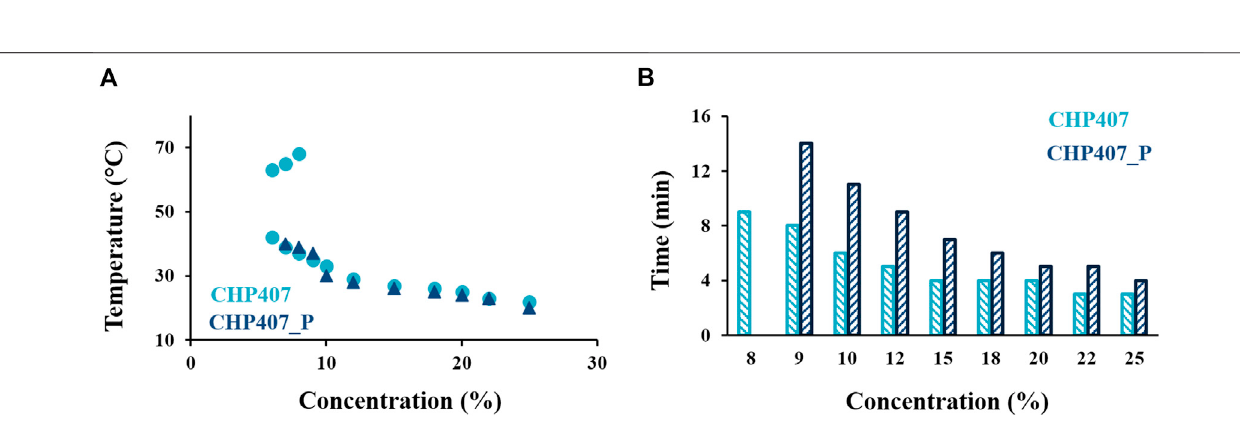
FIGURE 6 | Tube Inverting Test (A) conducted on CHP407 (light blue) and CHP407_P (dark blue) hydrogels (5% – 25% w/V concentration range in physiological saline solution) within 5 ° C – 70 ° C range (1 ° C/step, systematic error ± 0.5 ° C). Gelation time test (B) at physiological temperature (1 min/step, systematic error ± 30 s) performed on CHP407 (light blue) and CHP407_P (dark blue) hydrogels prepared by dissolving the polymer in physiological saline solution at different concentrations (5% – 25%